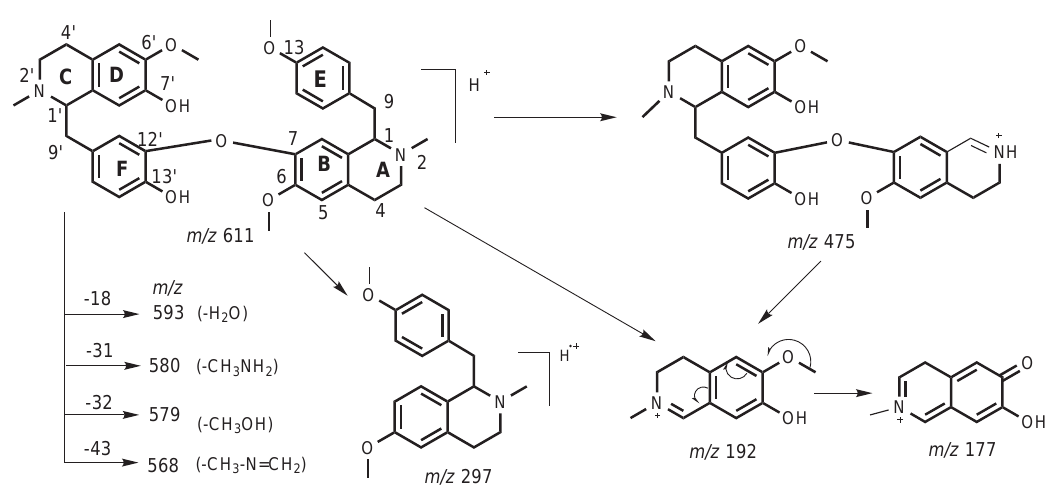
Scheme 1. Proposed fragmentation patterns of